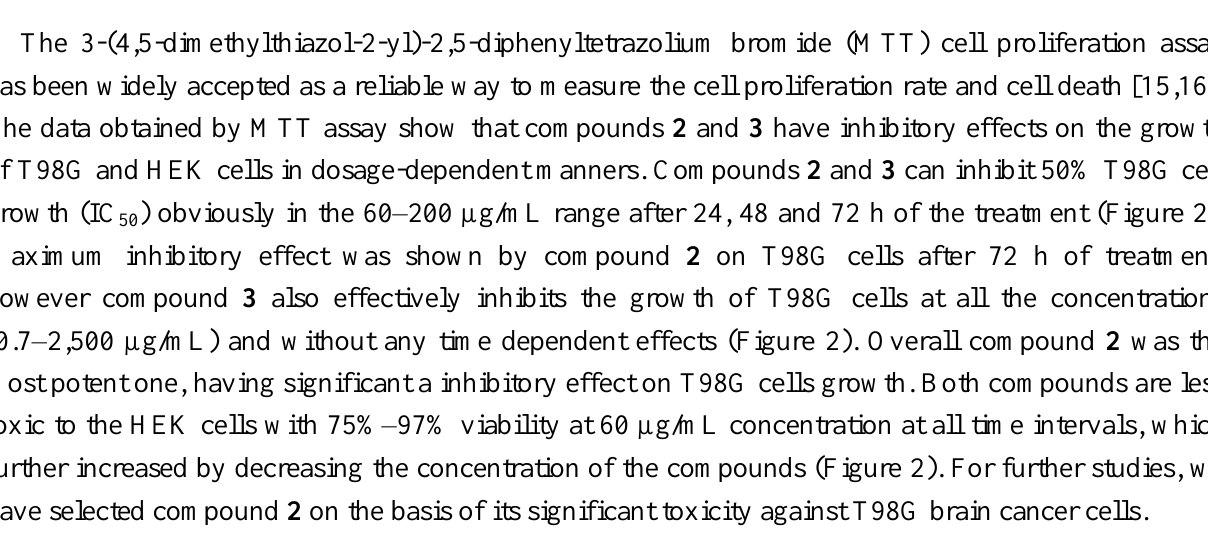
Figure 2. % Viability evaluated from MTT assay on T98G brain cancer and normal HEK cells treated with thienyl derivative for 24, 48, and 72